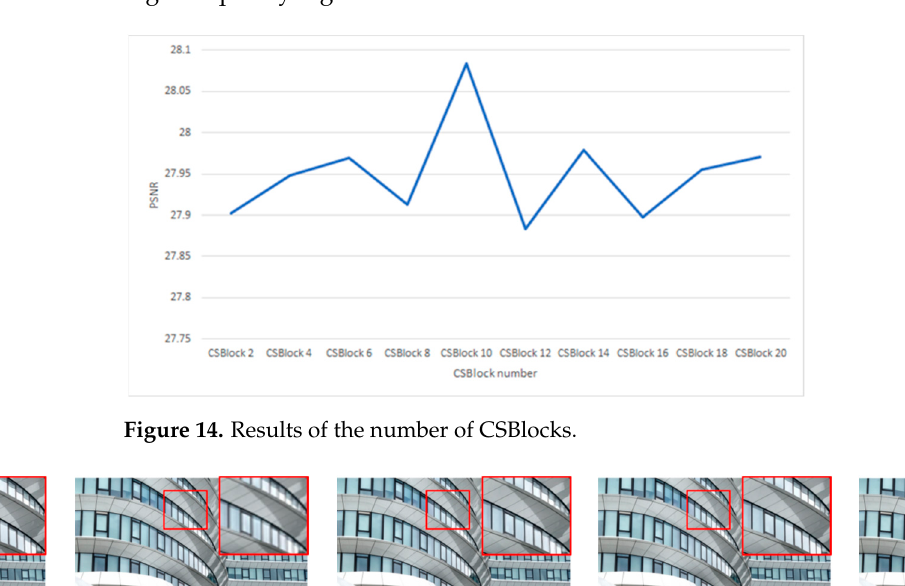
Figure 14. Results of the number of CSBlocks.